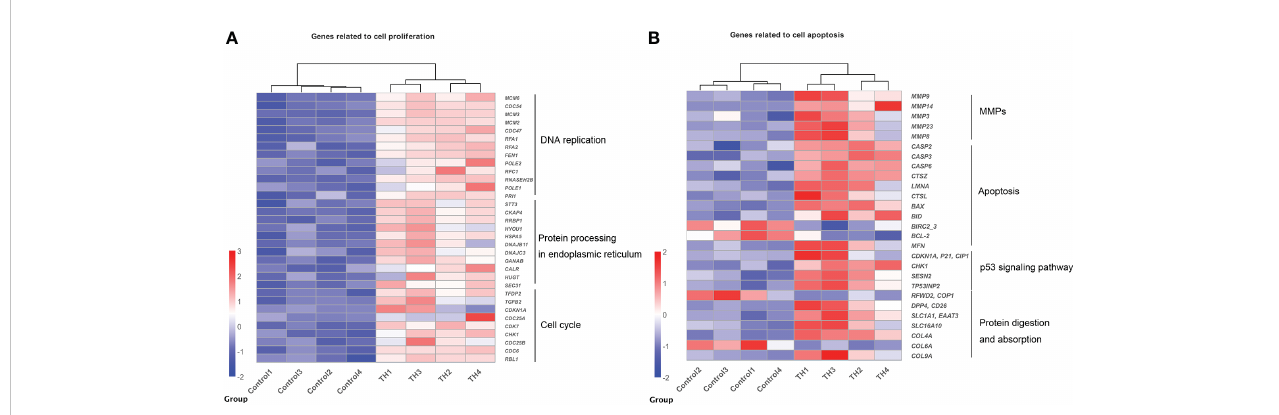
FIGURE 3 Heatmaps showing coordinated regulation of DETs in different cell processes between control group and TH treatment group. (A) A heatmap of all DETs related to cell proliferation, which includes DNA replication, protein process in endoplasmic reticulum, and cell cycle KEGG pathway. All genes were upregulated after TH exposure. (B) A heatmap of DETs related to cell apoptosis, which includes MMPs, apoptosis, p53 signaling pathway, and protein digestion and absorption KEGG pathway. Nearly all were upregulated after TH exposure except BIRC2_2 , BCL-2 , COP1 , and COL6A . The intensity of color indicates relative expression levels. Red to blue corresponds to high to low levels of expression. DETs, differentially expressed transcripts; TH, thyroid hormone; KEGG, Kyoto Encyclopedia of Genes and Genomes; MMPs, matrix metalloproteinases.